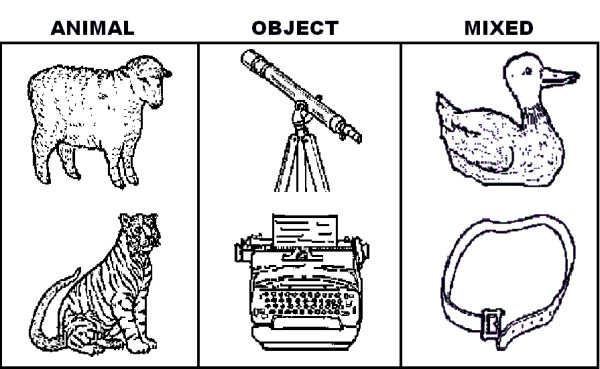
Example of stimuli belonging to the animal, artefact or distracter categories.